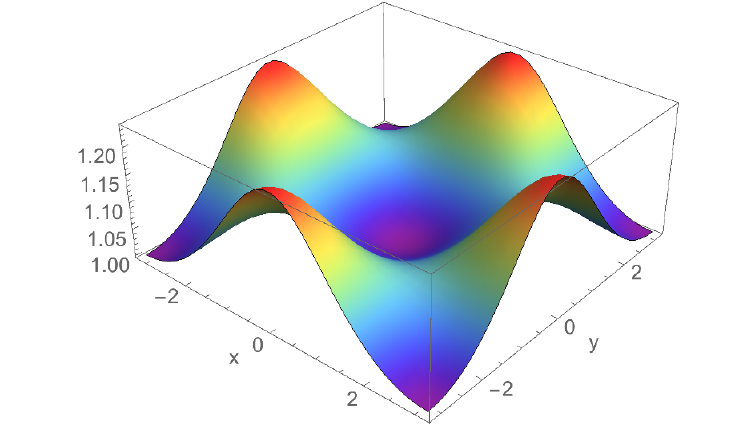
Figure 1 . Pro(cid:12)le of the lattice energy density a L ( x; y ) for a lattice (1.5) with A 0 = 0 : 3 in the interval [ (cid:0) (cid:25); (cid:25) ] 2